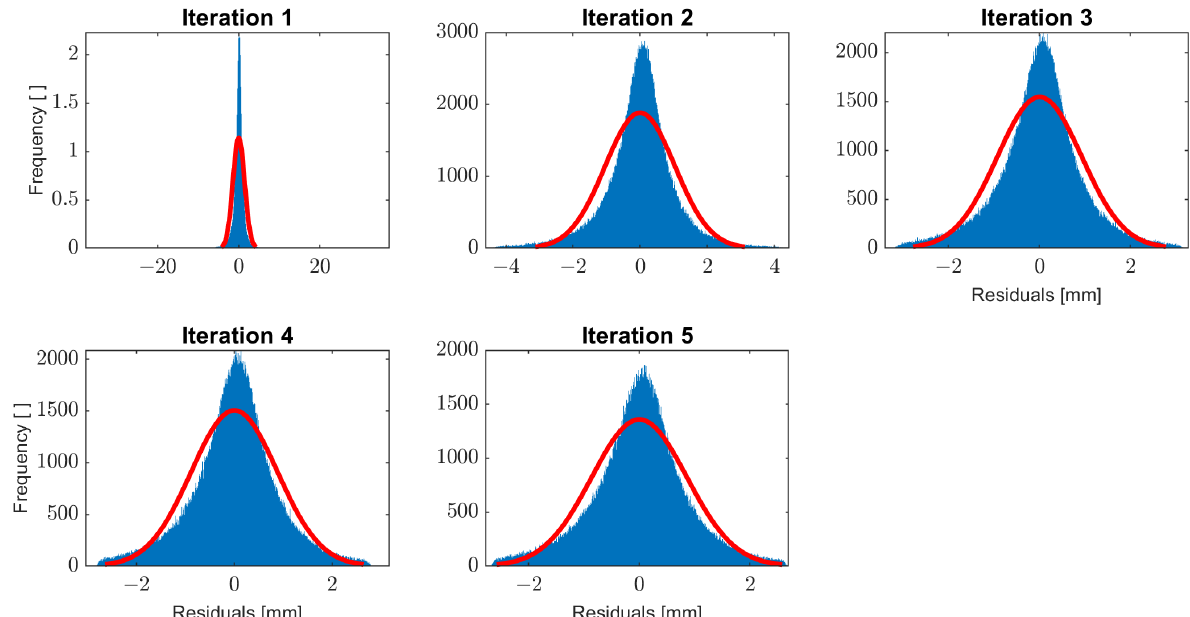
Figure 6. Histogram of residuals; the red lines shows the best-fitted normal distribution to the residuals at each iteration in the outlier detection algorithm.